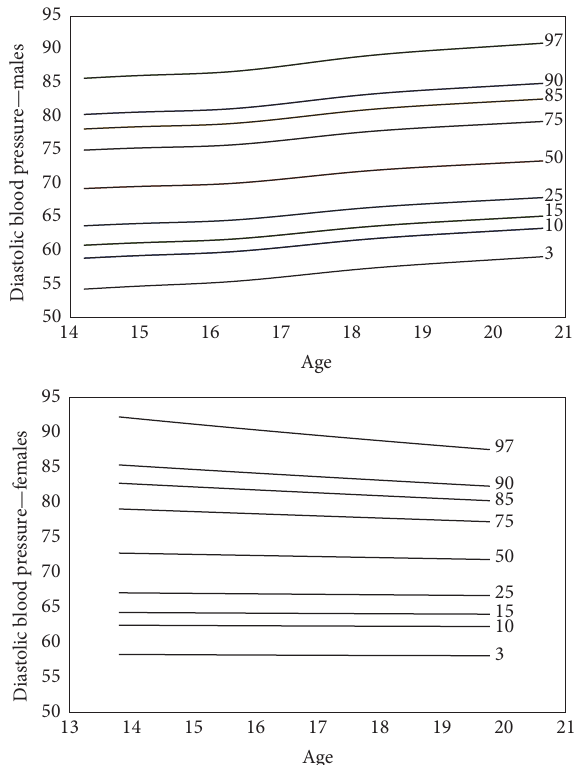
Figure 1: The smoothed standard percentiles of systolic blood pressure among 13–21-year-old adolescents of Jahrom city. Figure 2: The smoothed standard percentiles of diastolic blood pressure among 13–21-year-old adolescents of Jahrom